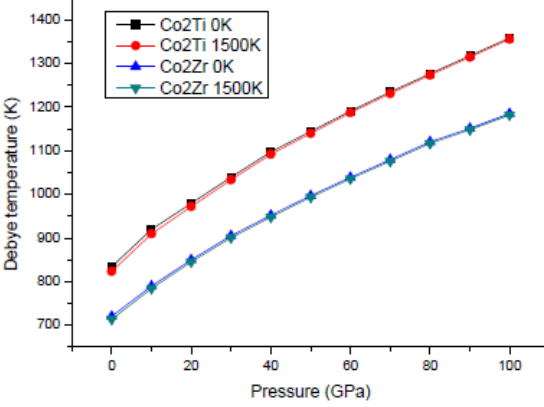
Figure 5. The Debye temperature as a function of temperature and pressure.